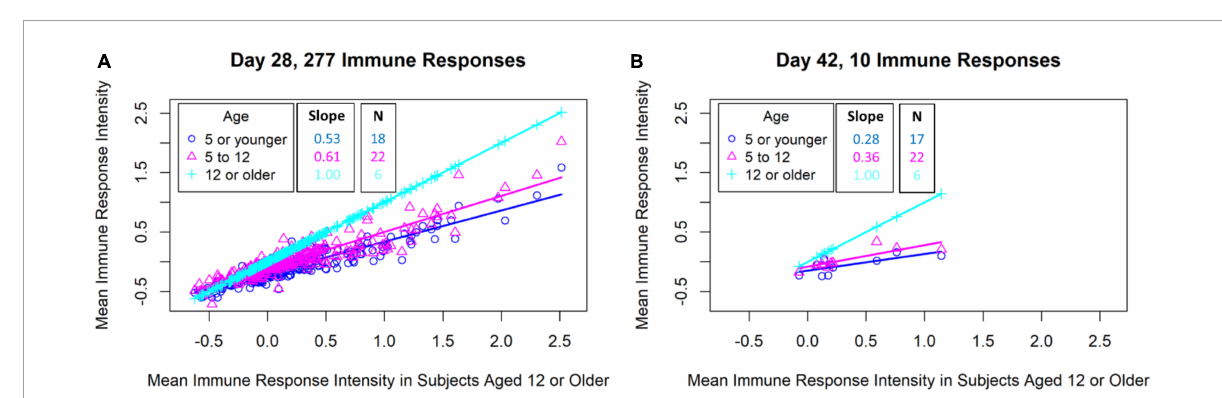
FIGURE4 Comparison of malaria antigen-specific antibody responses of subjects in different age groups. The mean antigen-specific antibody signal intensities to P falciparum proteins (identified through univariate analyses) from subjects in varying ages ( y -axis) were plotted against the mean intensities for the oldest subject group ( x -axis). (A) Scatterplot of mean antibody signal intensities of 277 P falciparum proteins associated with ASMQ outcomes on day 28. (B) Scatterplot of mean antibody signal intensities of 10 P falciparum proteins associated with ASMQ outcomes on day